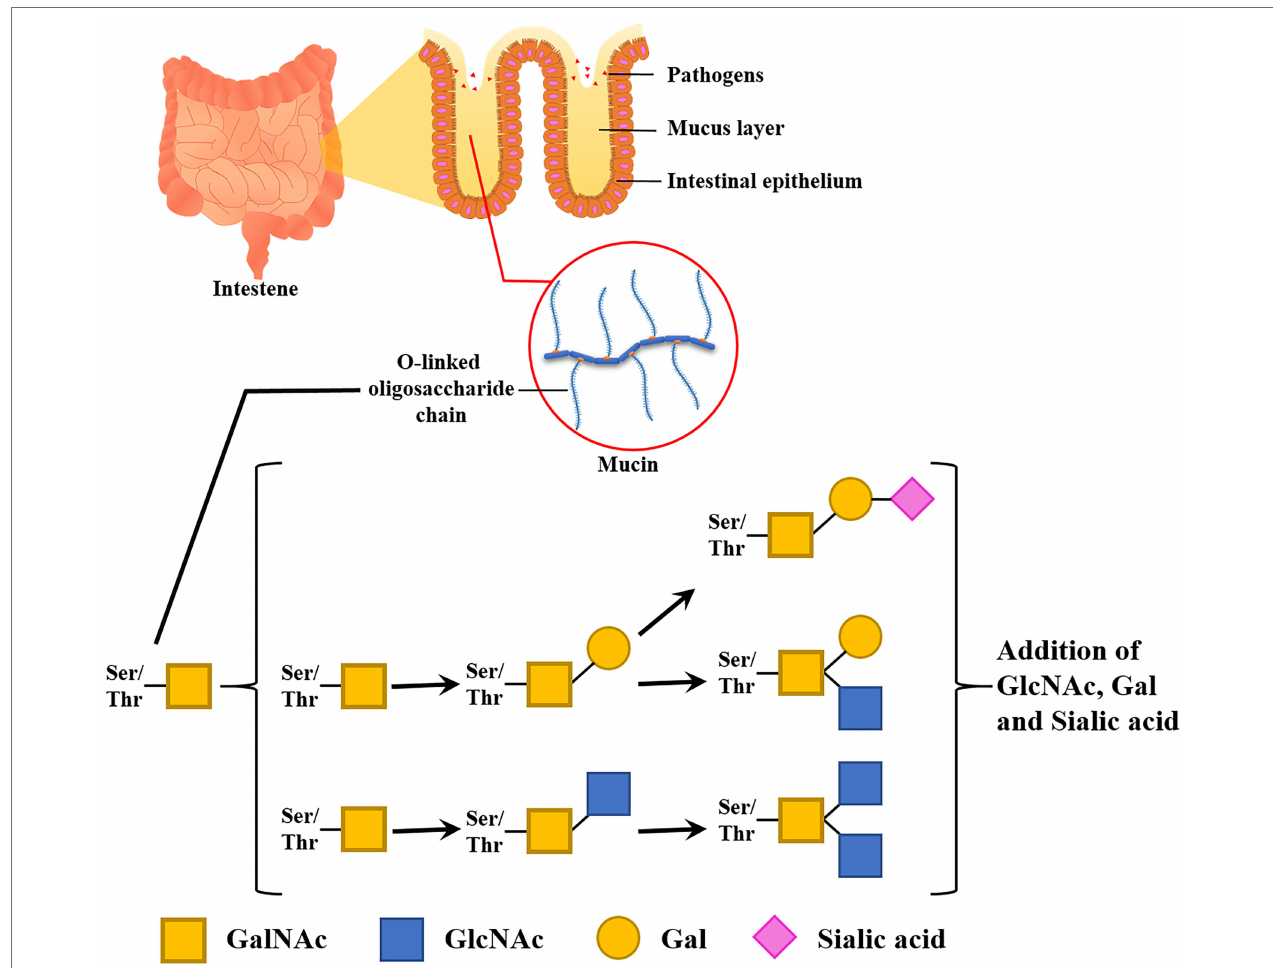
FIGURE 2 | Functions and compositions of intestinal glycan (mucin). A mucus layer covers the intestinal lumen. This thick layer prevents the epithelial cell layer from invading microbes. Glycan entraps pathogens and infectious microbes in its dense O-linked oligosaccharide